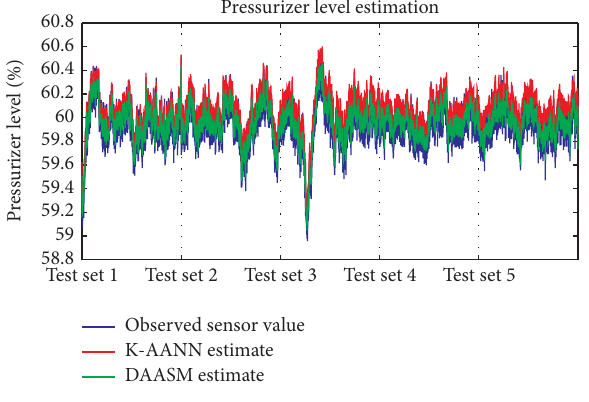
Figure 20: Pressurizer level estimates.